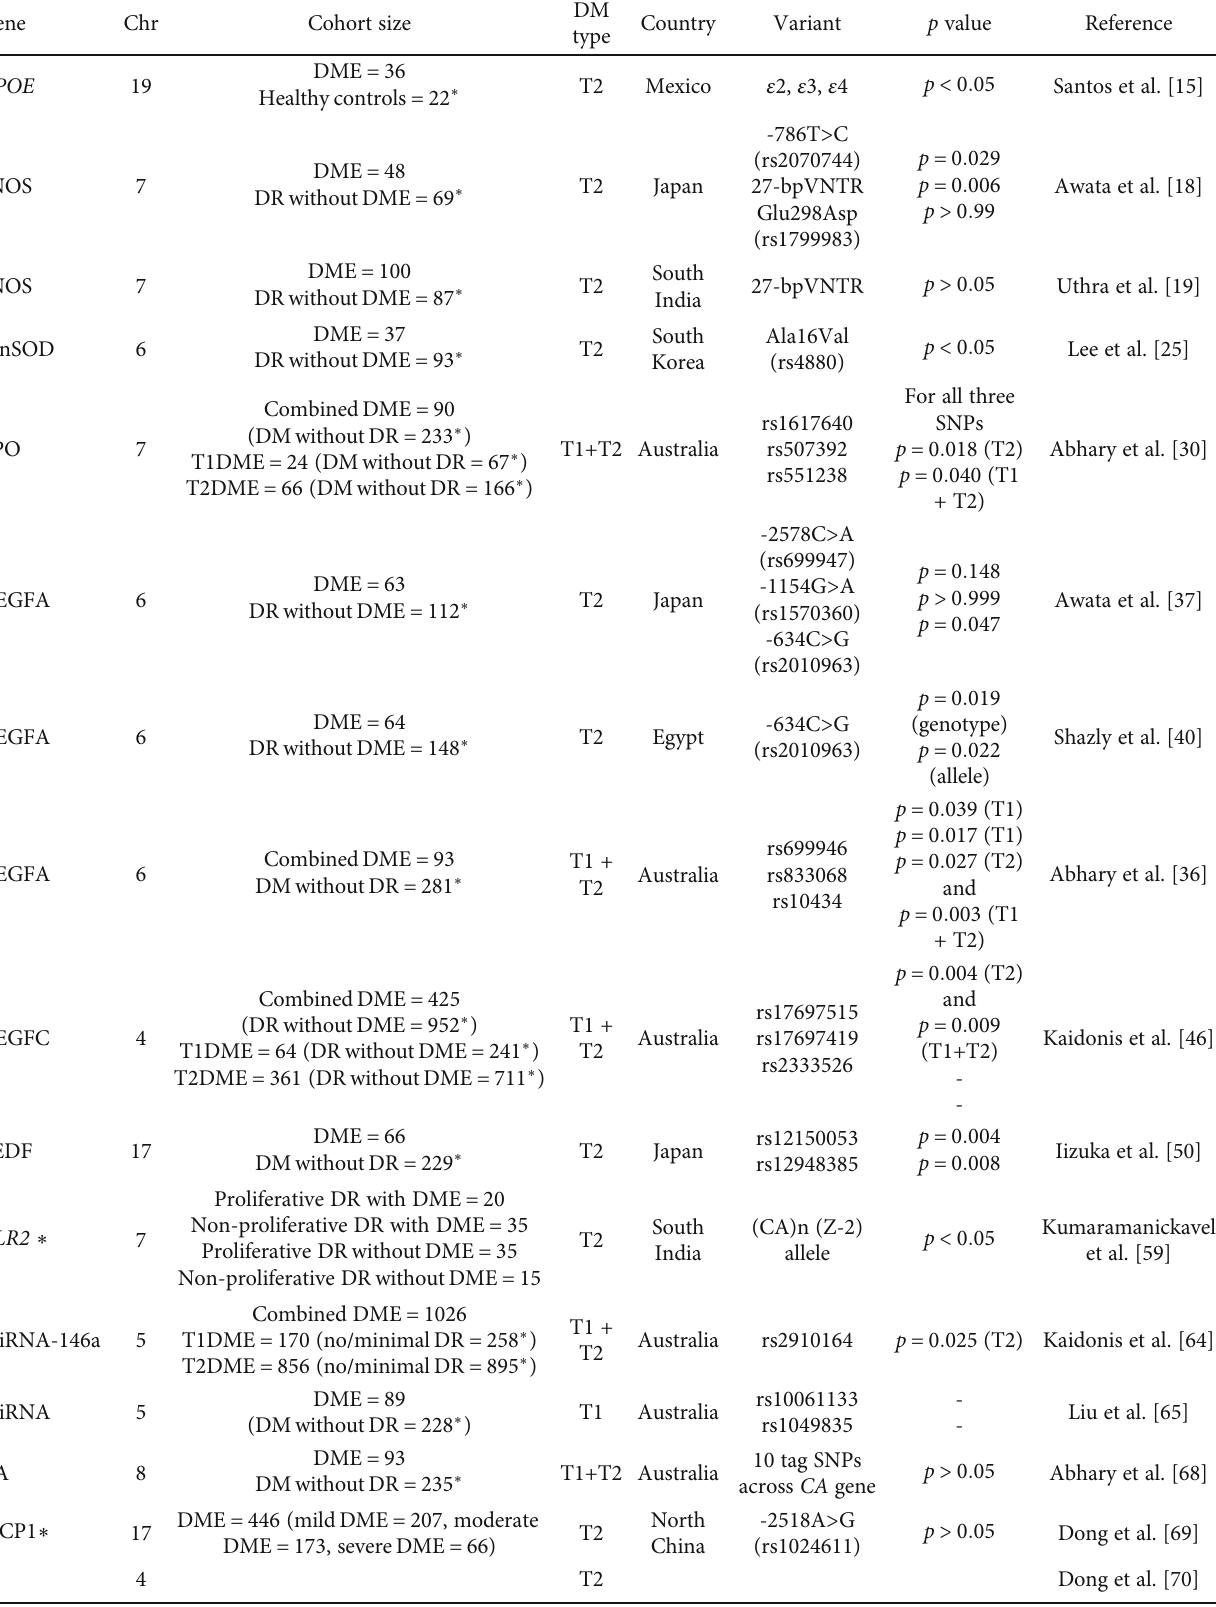
Table 1: Candidate genes evaluated for association with diabetic macular